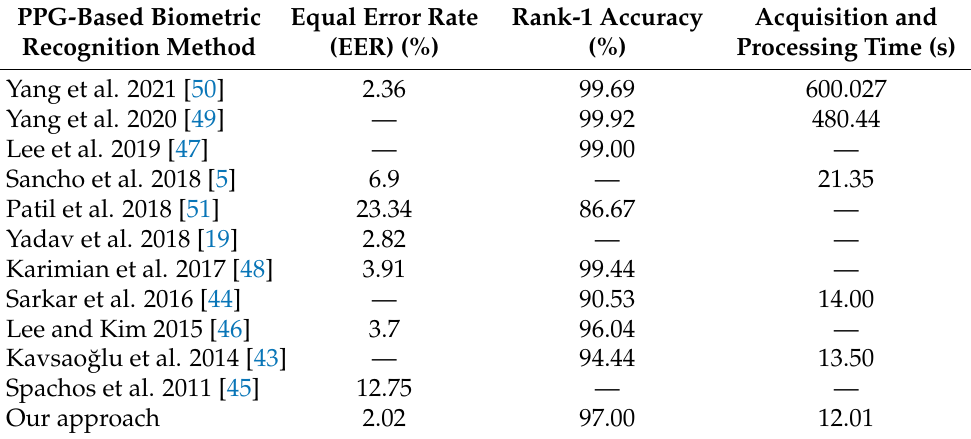
Table 4. The performance of recognition systems based on PPG with state-of-the-art methods compared. Claimed error rates (EERs) involve those in the trial; three attempts were allowed. Acquisition and processing time refers to the system’s time to identify whether the user is valid or